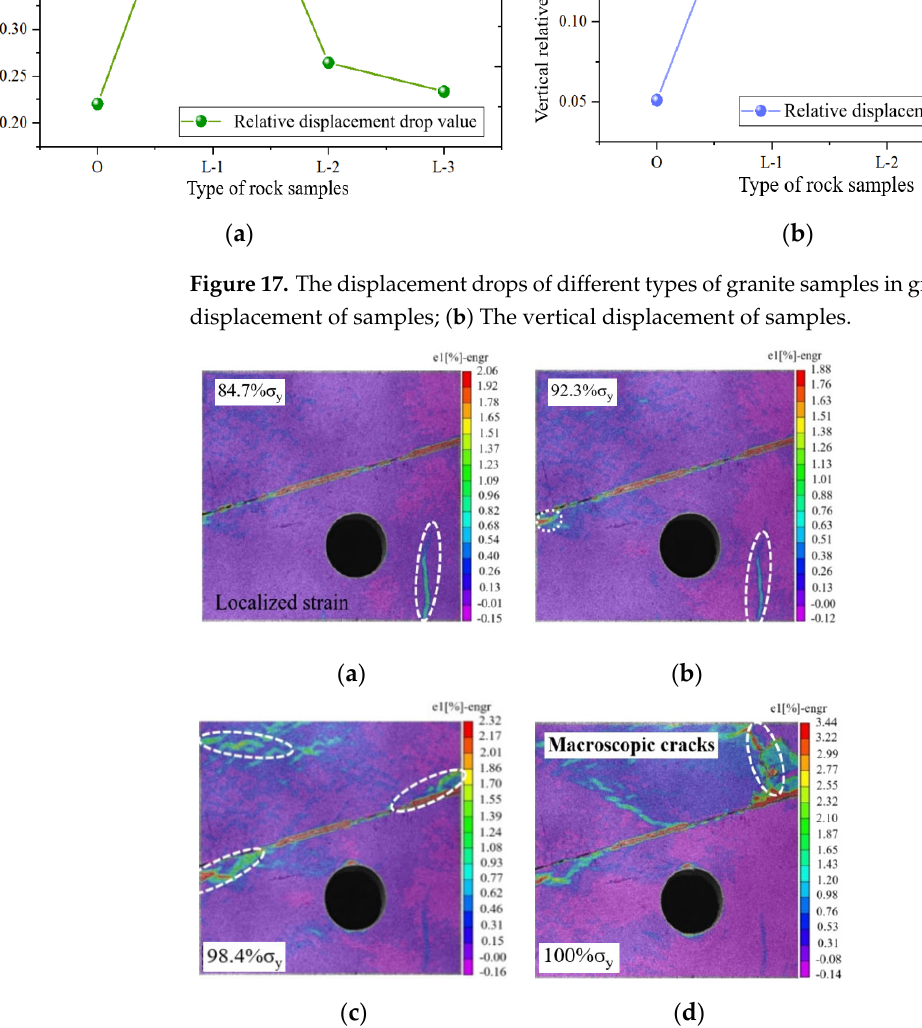
Figure 18. Evolution process of the major principal strain field of sample A ‐ 15. ( a ) 84.7% σ y ; ( b ) 92.3% σ y ; ( c ) 98.4% σ y ; ( d ) 100% σ y .